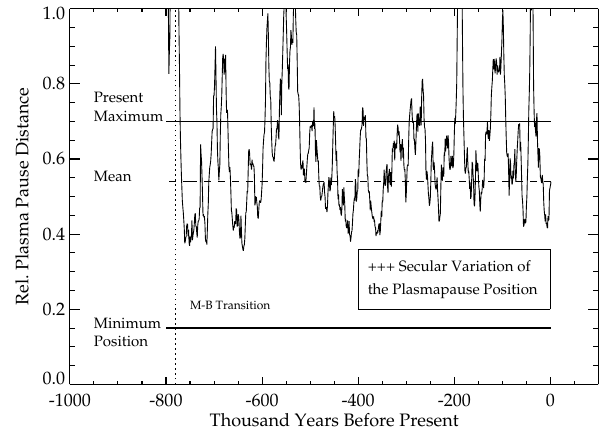
Fig. 3. Estimated relative plasmapause position over the past 800000 years using the Siscoe and Chen (1975) scaling relation, together with the current day plasmapause position and its variabil-